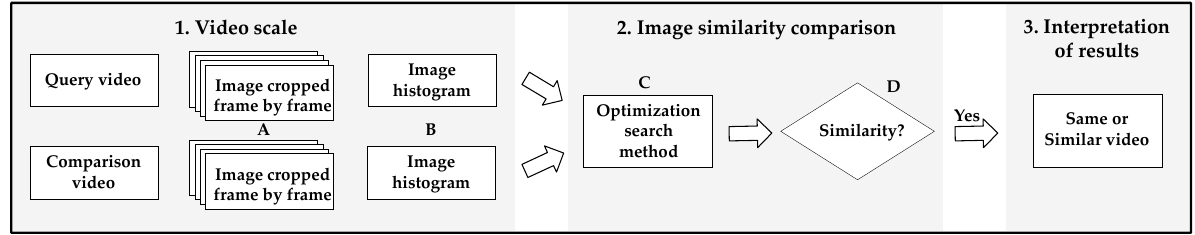
Figure 1. Overall process of video forensics.